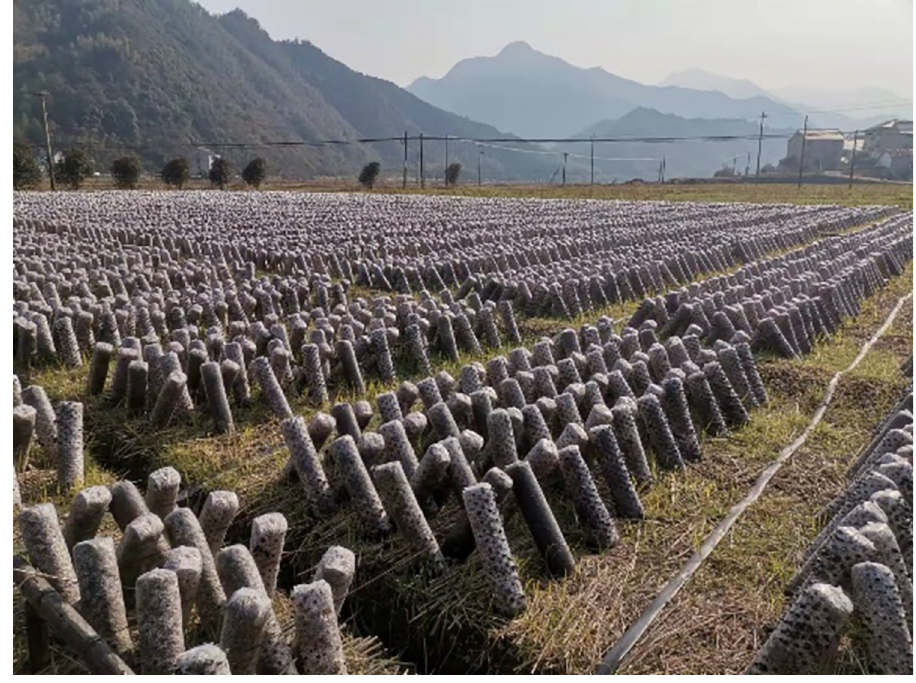
Fig 3. Black fungus sticks field.